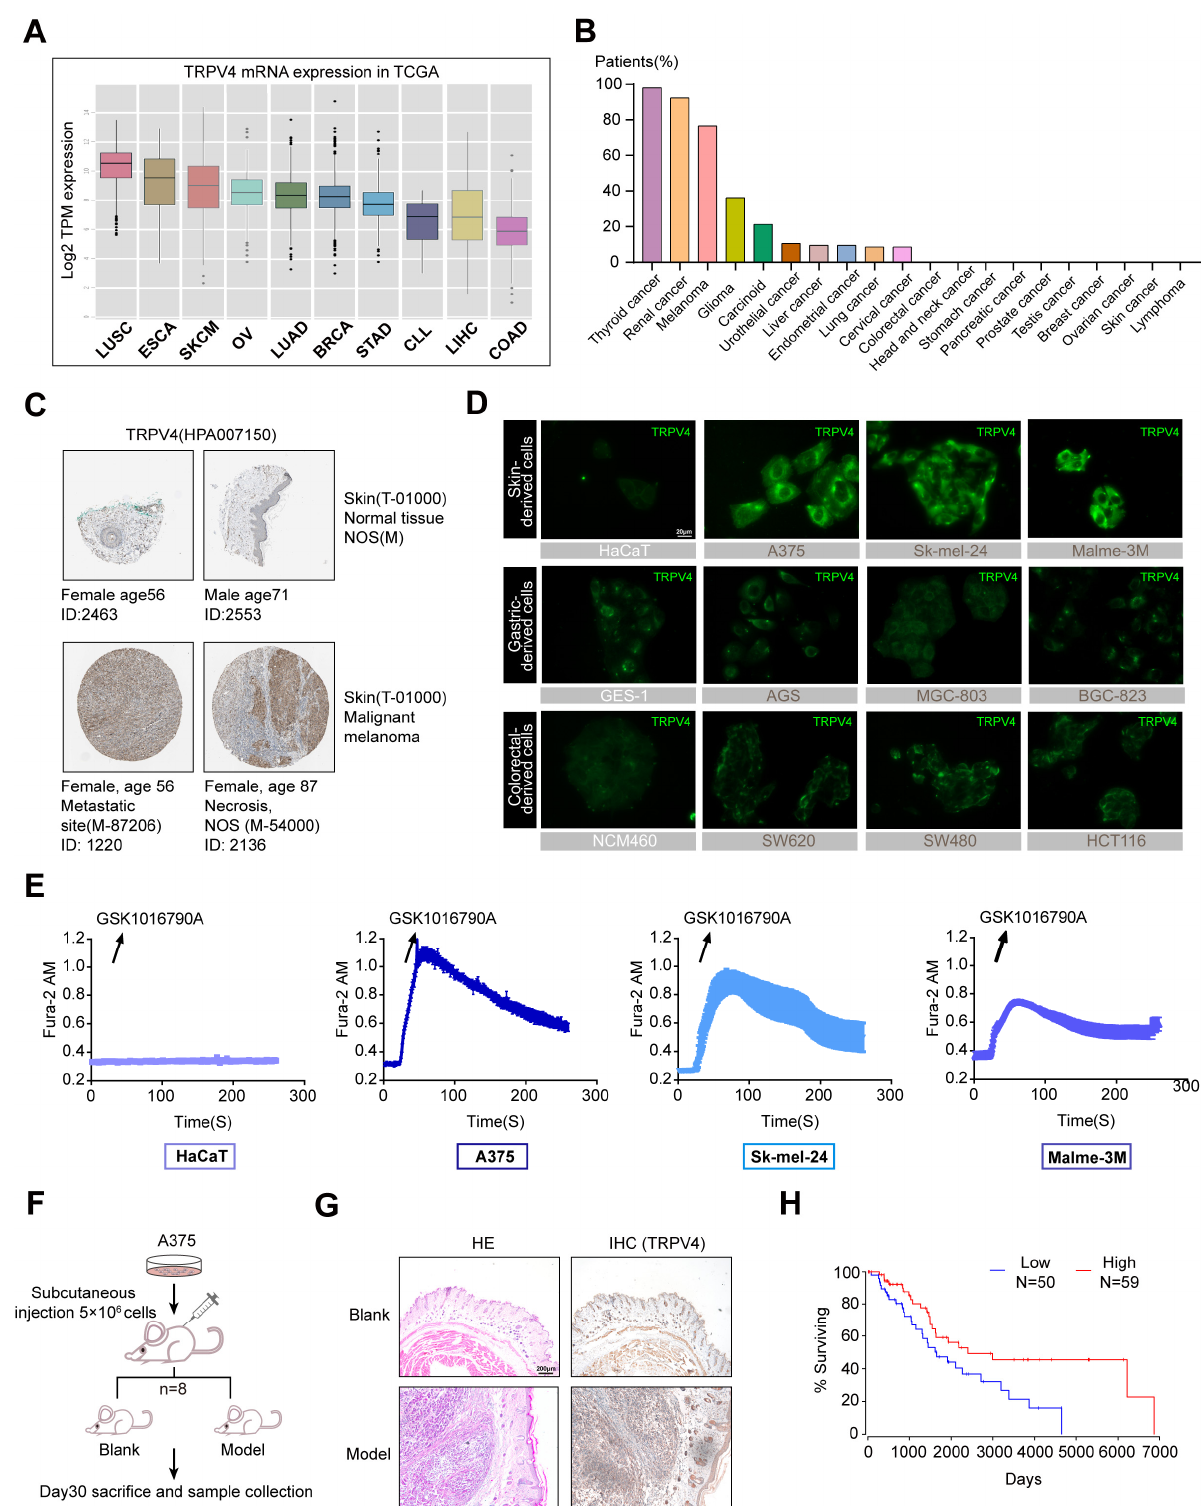
Figure 1. Up-regulation of TRPV4 in melanoma. ( A ) TRPV4 mRNA expression level in different cancer tissues in TCGA. ( B ) TRPV4 protein expression level in different human cancerous and adjacent non-cancerous/normal tissue in terms of The Human Protein Atlas. ( C ) Strong immunoreactivity was observed in melanoma patients. ( D ) Representative images of TRPV4 expression (green) in multiple cells (Above: Skin-derived cell lines, HaCaT, A375, SK-mel-24, Malme-3M; Middle: Gastric-derived cell lines, GES-1, AGS, MGC-803, BGC-823; Below: Colorectal-derived cell lines, NCM460, SW620,